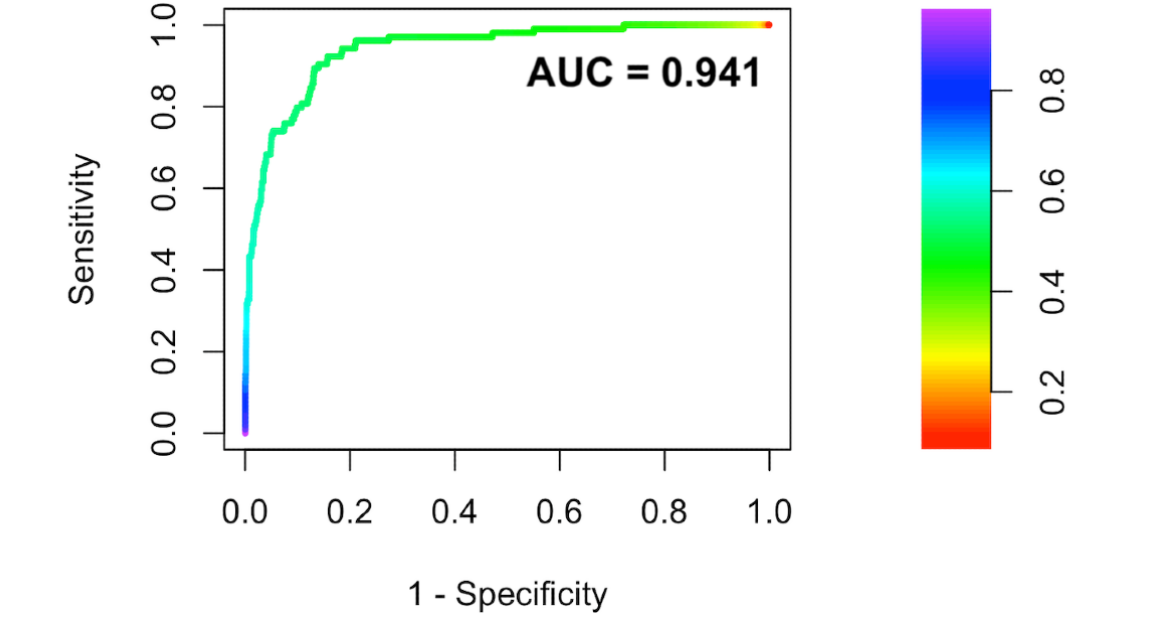
Figure 3. Receiver operator characteristic curve for neural network prediction of exceeding the American Academy of Pediatrics–recommended phototherapy initiation threshold on the subsequent bilirubin measurement in newborn infants ≥ 35 weeks of gestation. The area under the receiver operator characteristic curve was 0.941 (95% CI 0.910 to 0.973); a no-skill classifier would have an area under the receiver operator characteristic curve of 0.5. The color represents the decision threshold value corresponding to the sensitivity and specificity on the receiver operator characteristic curve. AUROC: area under the receiver operator characteristic curve; ROC: Receiver operator